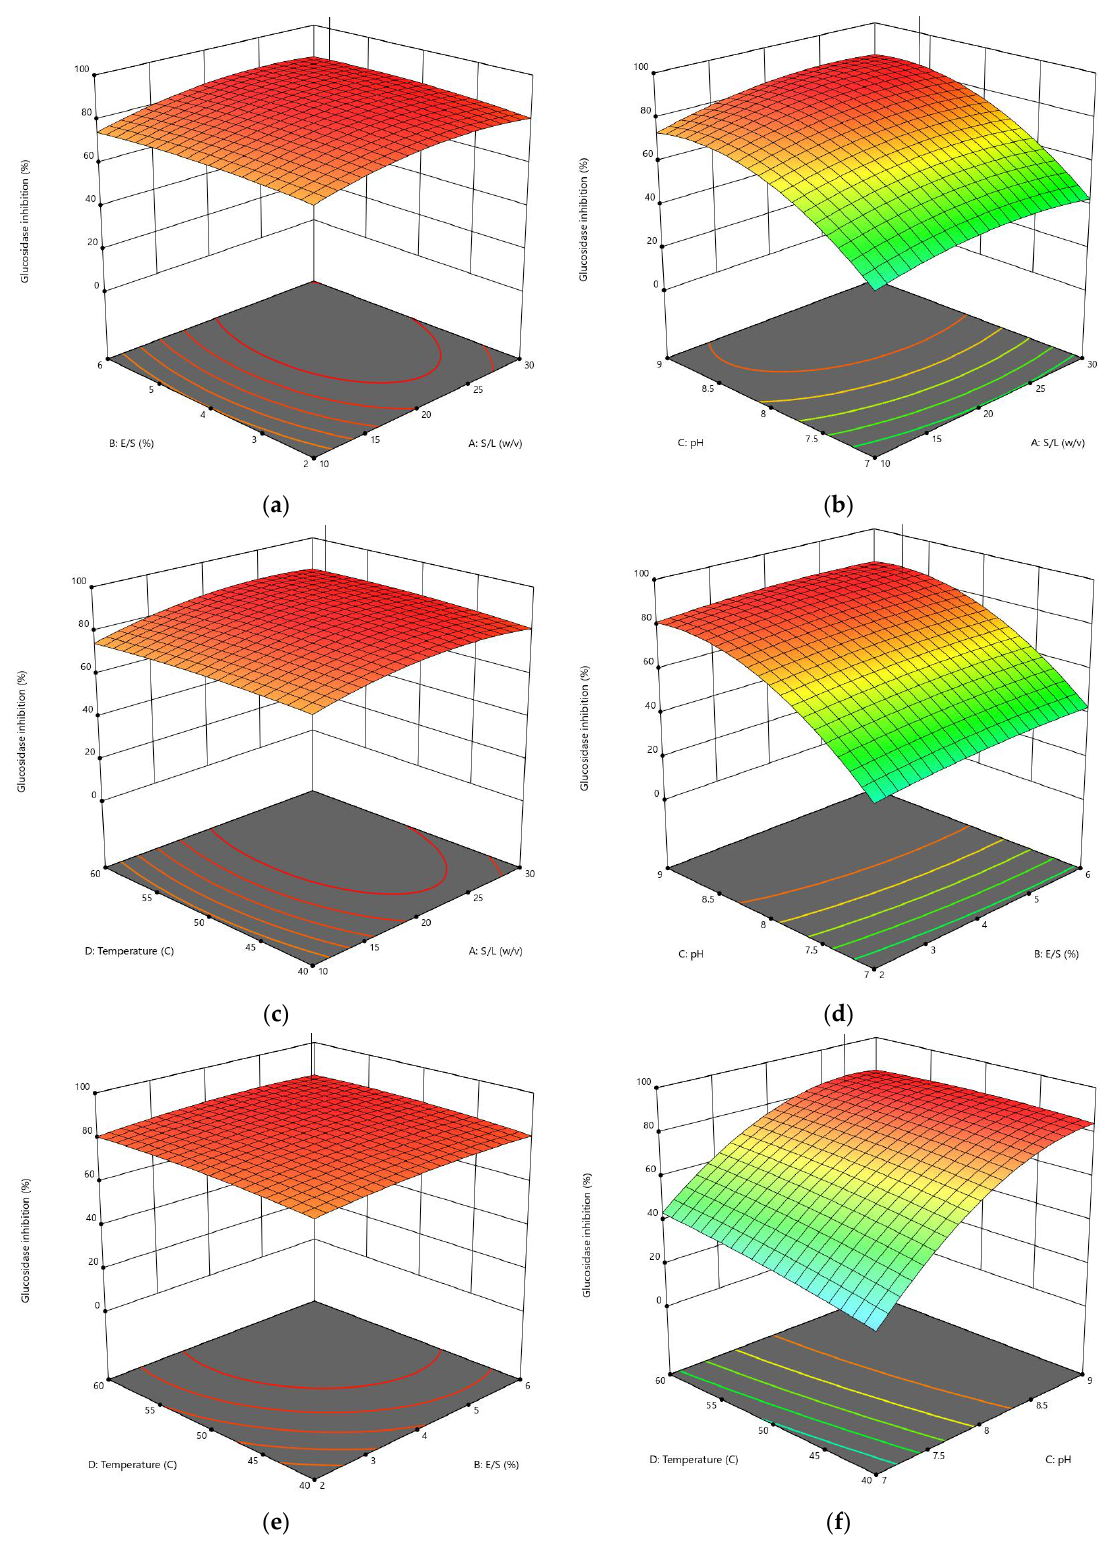
Figure 6. 3D response surface plots showing the influence of variable parameters on the α -glucosidase inhibition activity response using trypsin: ( a ) E/S ratio vs. S/L ratio, ( b ) pH vs. S/L ratio, ( c ) temperature vs. S/L ratio, ( d ) pH vs. E/S ratio, ( e ) temperature vs. S/L ratio and ( f ) temperature vs. pH.